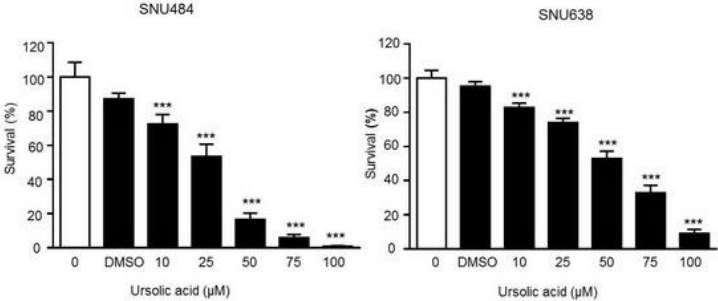
Figure 1. Ursolic acid (UA) inhibited gastric cancer cell growth. Human gastric cancer SNU484 and SNU638 cells were treated with UA (0, 10, 25, 50, 75, and 100 μM) and cell proliferation was detected by MTT assays. Data are mean (SE) of > 3 independent experiments with triplicate dishes. *** p < 0.01 compared with the control.